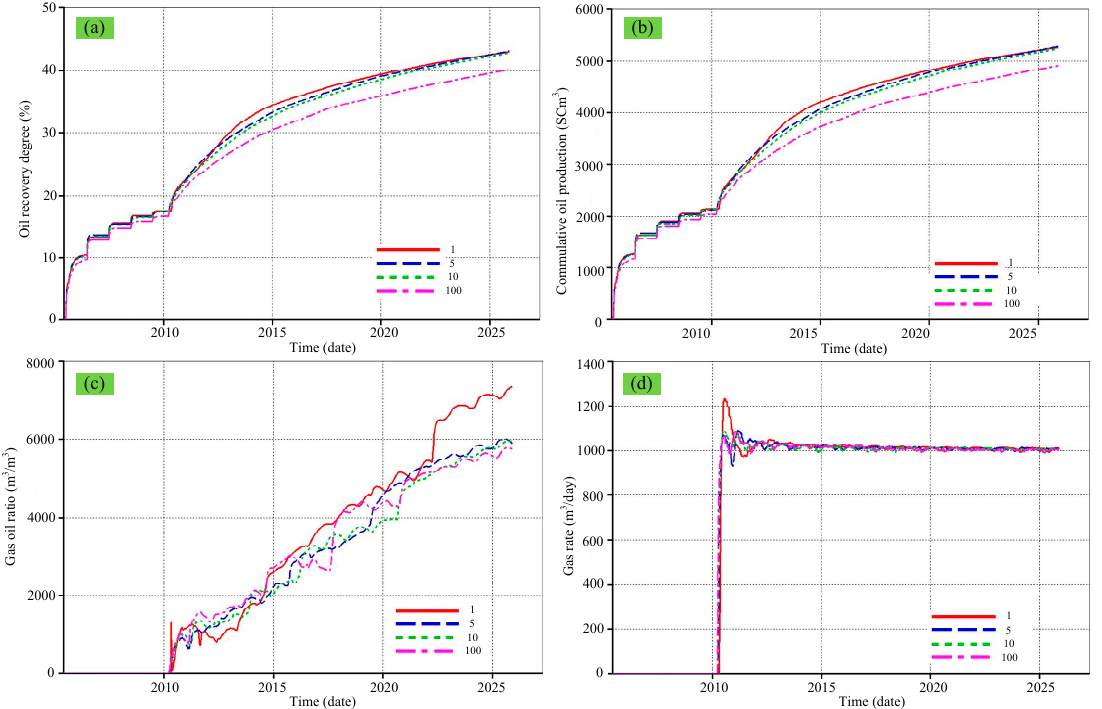
Figure 10. Comparison of production indicators under di ff erent permeability ratio. ( a ) recovery degree; ( b ) cumulative oil production; ( c ) gas-oil ratio; and ( d ) gas production rate. Table 15. Dynamic production indicators under di ff erent permeability